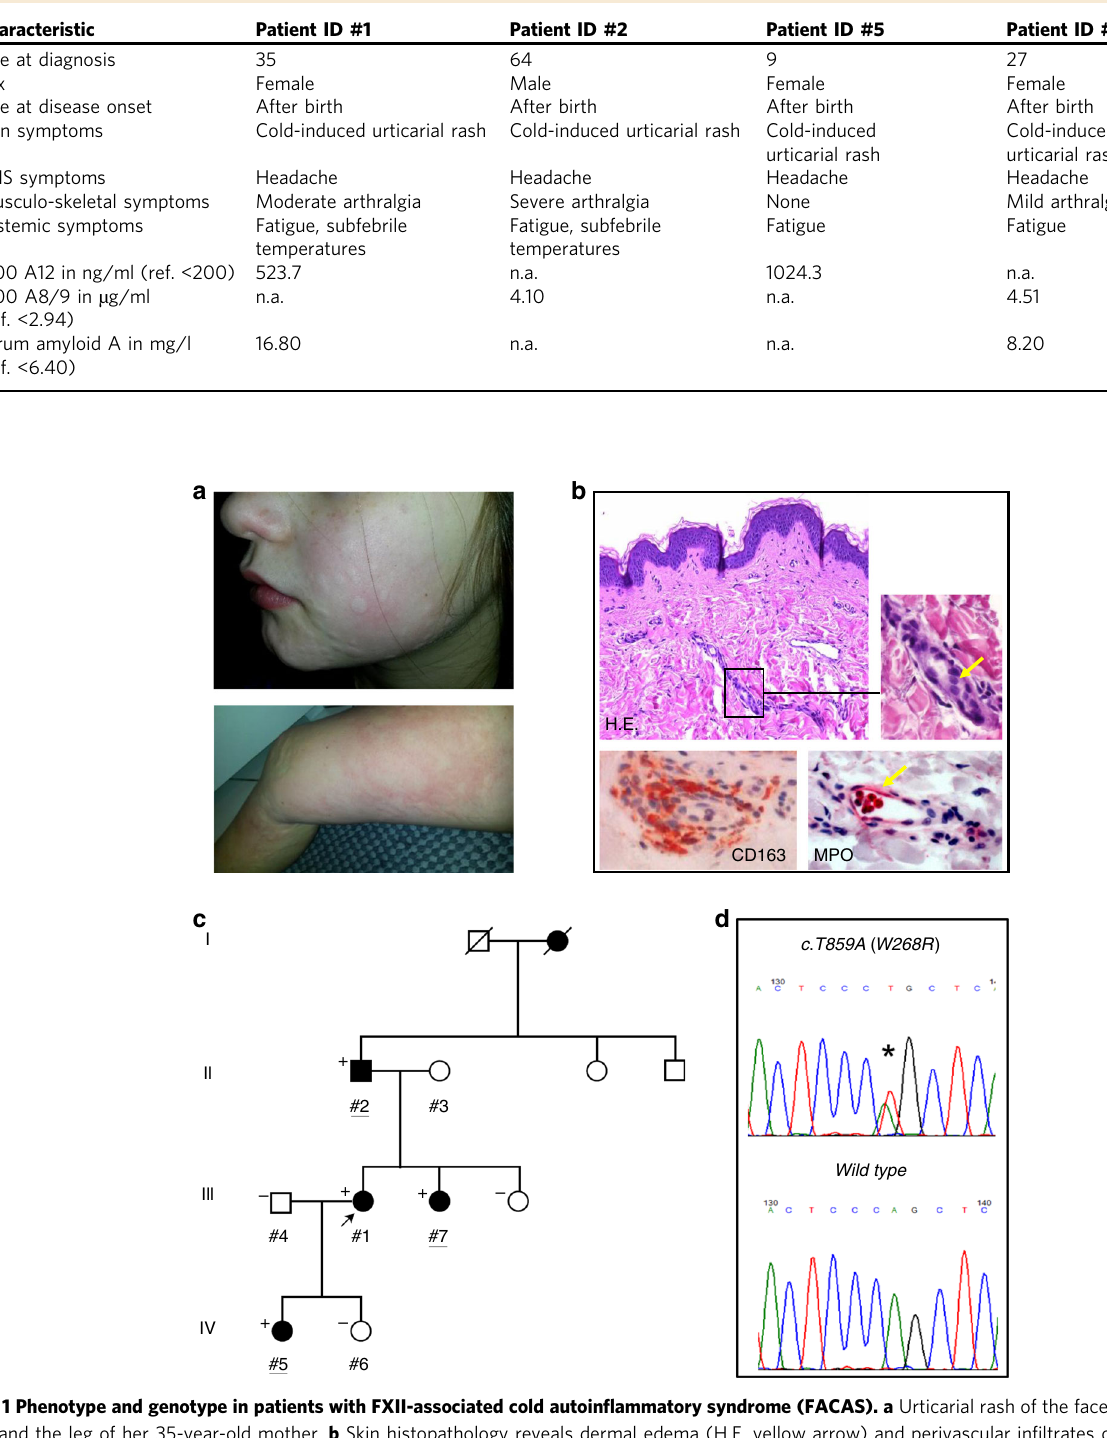
Table 1 Individual clinical characteristics and manifestations in FACAS patients.